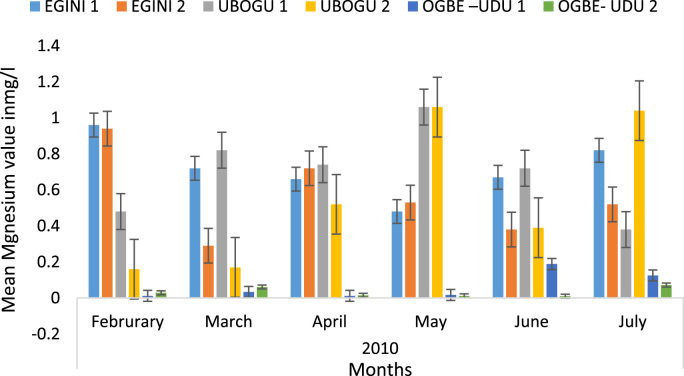
Mean Temporal and spatial variations in magnesium value.